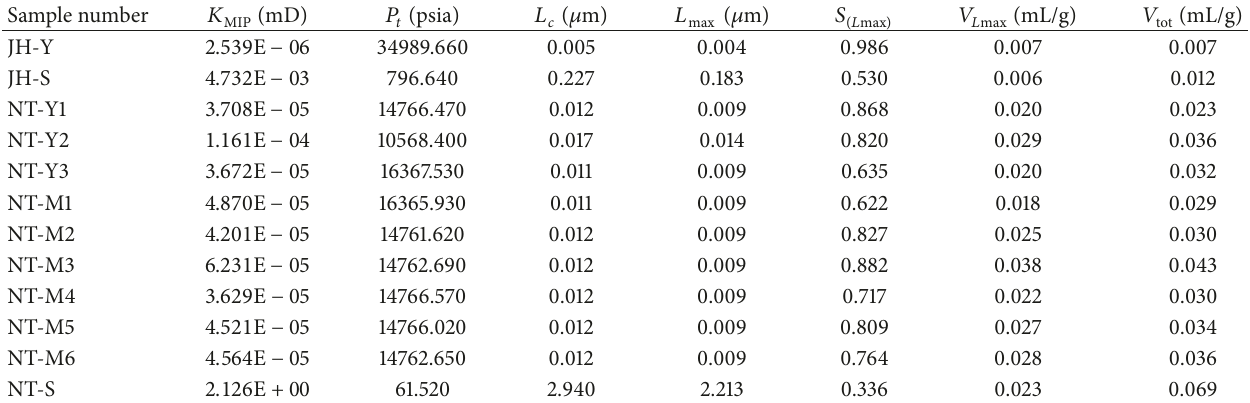
) and other related parameters in MIP